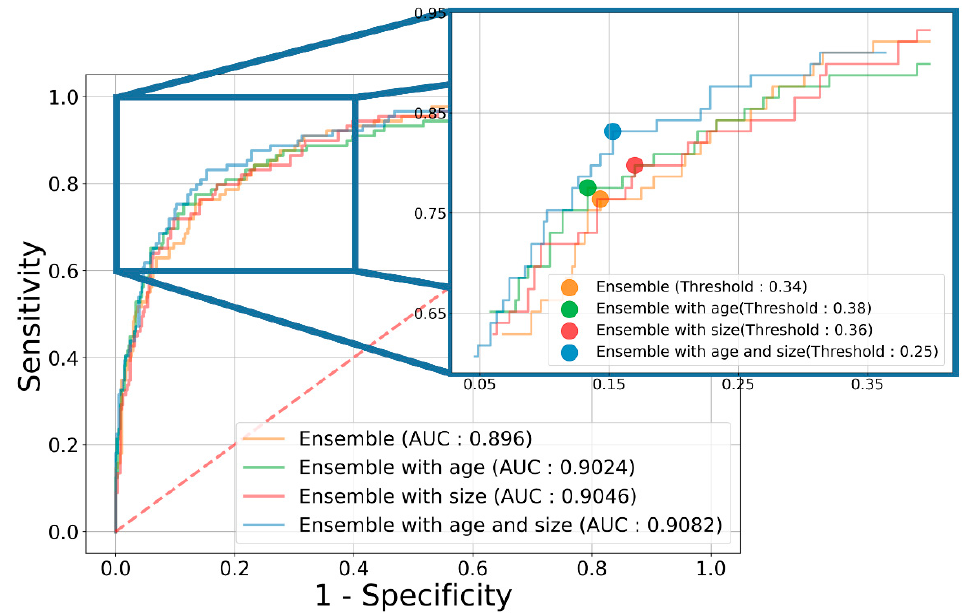
Figure 5. ROC curves of ensemble model according to the addition of clinical information. The orange, green, red, and blue lines show the results from the ensemble model without clinical information, with patient age, with polyp size, and with both, respectively.